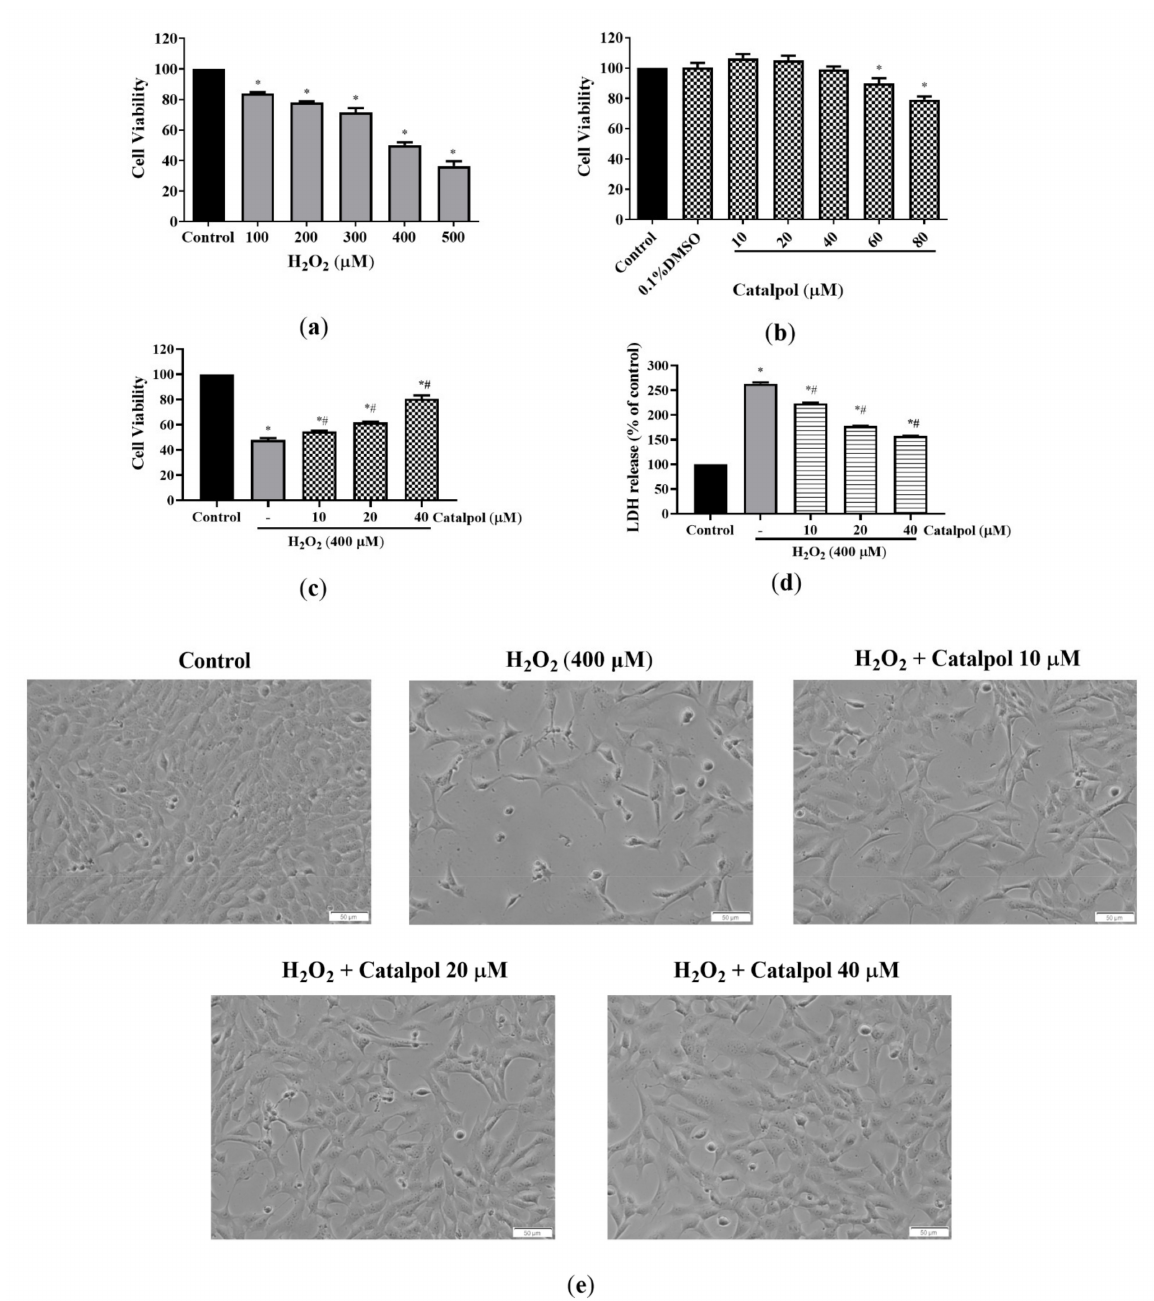
Figure 1. Catalpol protected RPE cells from H 2 O 2 -induced cell damage. ( a ) ARPE-19 cells were first exposed to different concentrations of H 2 O 2 (100, 200, 300, 400, and 500 µ M) for 6 h, and cell viability was determined with MTT assay. ( b ) Effect of different concentrations of catalpol on ARPE-19 cell viability. ( c ) Cytoprotective effect of catalpol. ARPE-19 cells were pretreated with varying concentrations of catalpol (10, 20, and 40 µ M) for 24 h, and then H 2 O 2 (400 µ M) was added and the treatment was continued for 6 h. Cell viability was measured with MTT assay. ( d ) ARPE-19 cells were pretreated with catalpol (10–40 µ M) for 24 h before being exposed to H 2 O 2 (400 µ M) for 6 h. The release of LDH was measured using an LDH cytotoxicity assay kit. ( e ) Changes in the number of ARPE-19 cells were observed and presented (original magnification: 200 × ). Data are presented as mean ± S.D. of three independent experiments (* p < 0.05 vs. control group, # p < 0.05 vs. H 2 O 2 (400 µ M)-treated